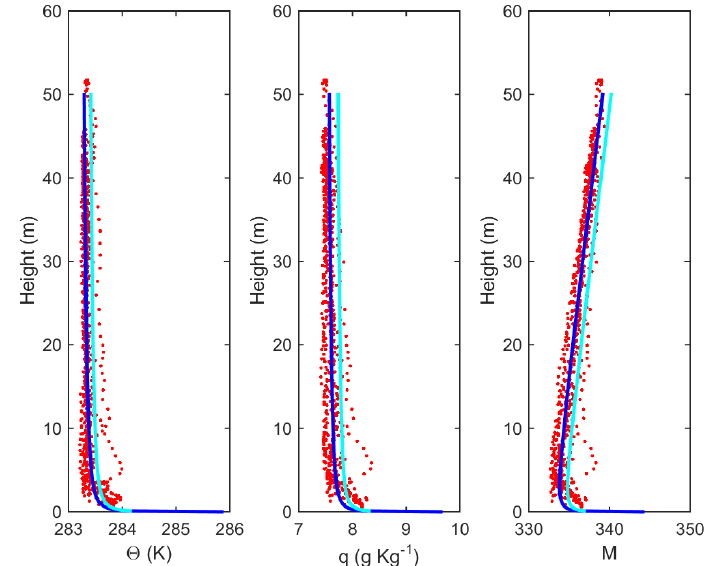
Figure 2. The results of the MOST model using measurements at two levels. The blue and cyan lines are the corresponding results of input from mean values at 9 m and 11 m and at 1 m and 3 m, respectively. The sampled data are in red. The modified refraction, M, has no unit.